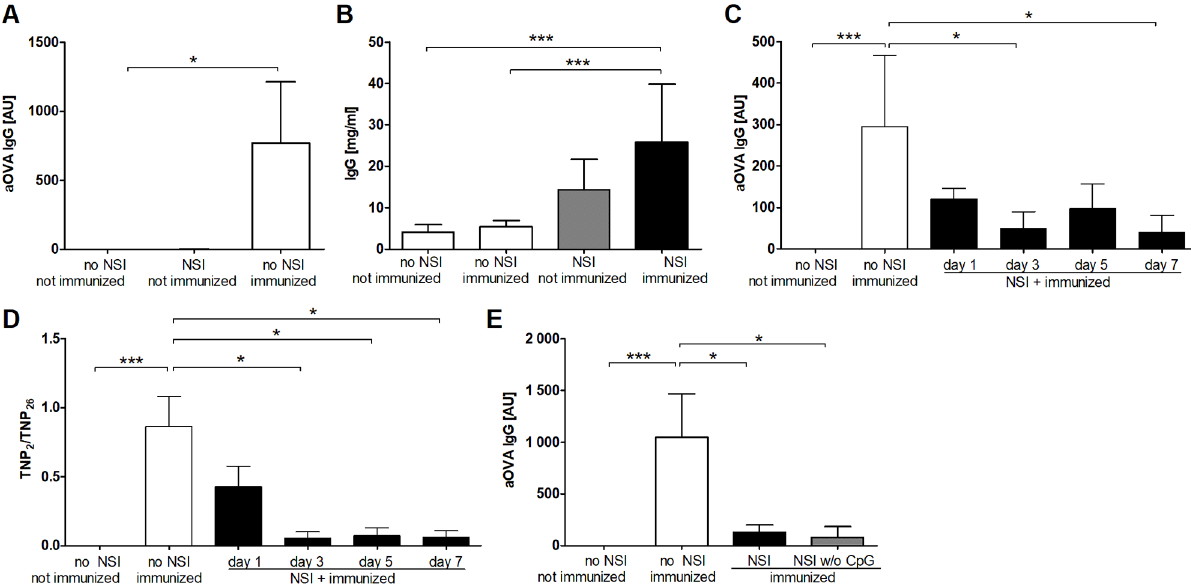
Fig 5. Suppression of the adaptive immune response after non-specific immunization. (A, B) NSI alone did not induce OVA-specific serum antibodies but increased total serum IgG. OVA-specific IgG (A) and total serum IgG (B) were measured 21 days after NSI (n = 3). Animals without NSI and immunization (n = 3 and 6), only immunized animals (n = 5 and 11), and animals immunized 7 days after NSI (n = 6 and 11) served as controls. (C, D) NSI reduced the specific response to antigen priming. C57BL/6 mice were non-specifically immunized (NSI, adapted from [29]). At the indicated time points after NSI, the animals were primed intraperitoneally with TNP-OVA/OVA in alum (n = 5–6). Animals without NSI and immunization (n = 6) and animals immunized without prior NSI (n = 5) served as controls. The antigen-specific immune response was measured as the concentration of anti-OVA IgG in the serum 14 days after priming with OVA by an ELISA. (C) The relative concentrations of OVA-specific IgG antibodies in serum normalized to a standard serum (arbitrary unit, AU) are shown. (D) The relative antibody affinity of TNP-specific IgG was measured as binding to slightly haptenized TNP-BSA in comparison to highly haptenized TNP-BSA in an ELISA (adapted from [34]). (E) The NSI- induced immune suppression was independent of CpG. C57BL/6 mice were treated with NSI containing CpG (NSI, n = 12) or not (NSI w/o CpG, n = 6). Seven days later, they were immunized intraperitoneally with TNP-OVA/OVA in alum (OVA). Mice without NSI and immunization (n = 7) and animals immunized only (n = 9) served as controls. The antigen-specific immune response was determined as described for panel C. In the panels A-D means and 95% confidence intervals are shown. Kruskal-Wallis test and Dunn’s multiple comparison for selected pairs. In panels B and E pooled results from two separate experiments are shown. (cid:3)(cid:3)(cid:3) P < 0.001; (cid:3) P <